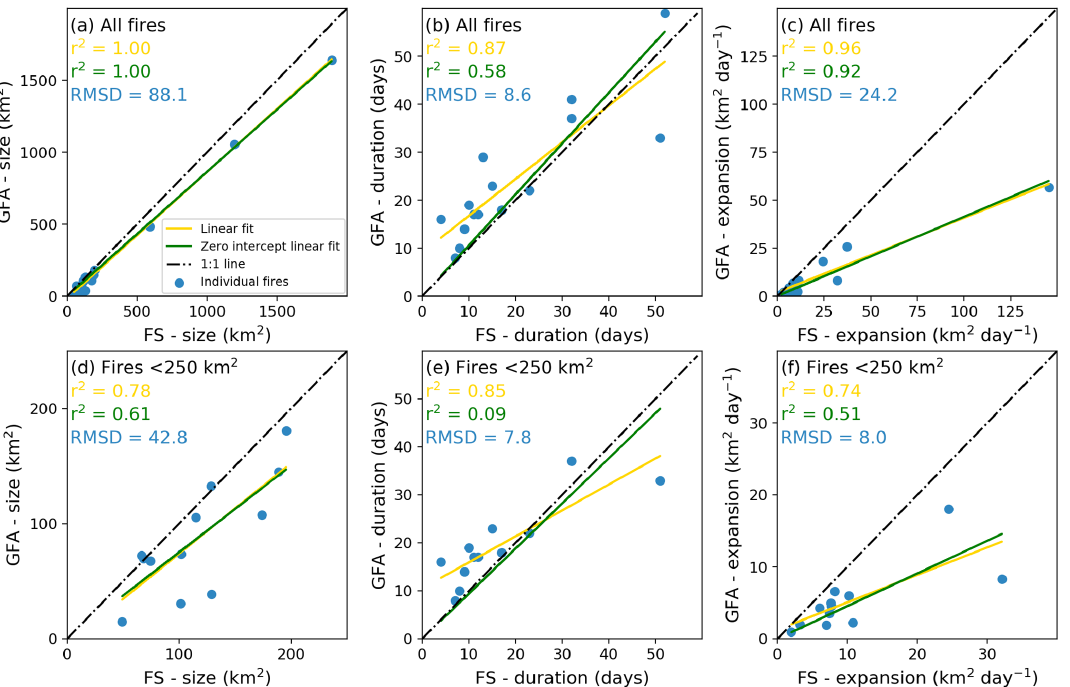
Figure 7. Comparison of Global Fire Atlas (GFA) and US Forest Service (FS) data for a selected number of large wildfires in the US. Comparison of (a) fire size, (b) duration and (c) average daily expansion rate for all fires ( N = 15); (d) , (e) and (f) are like (a) , (b) and (c) but for fires smaller than 250km 2 ( N = 12). Correlation coefficients are provided based on linear regression with (yellow) and without (green) an intercept, assuming a nonzero intercept could indicate a structural offset between both datasets. Root-mean-square deviations (RMSD) are reported in blue.